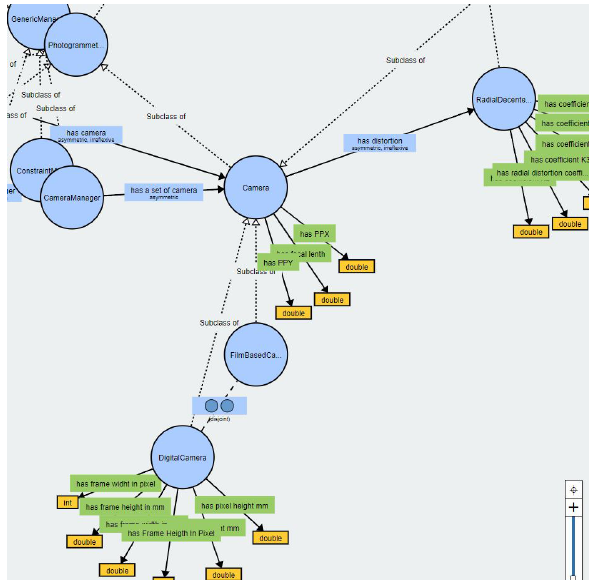
Figure 4. Partial View of the Photogrammetry Pro- file in